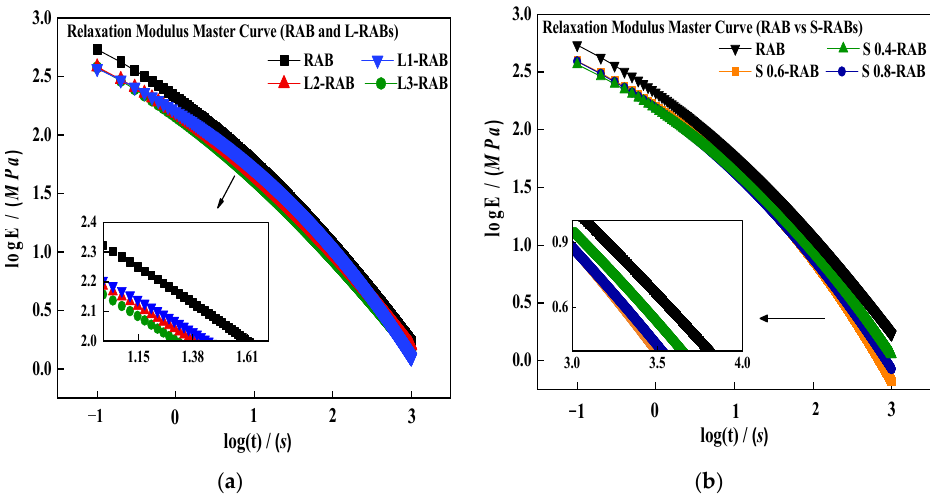
Figure 7. The master curves of 𝐸(𝑡) for W-RABs at a reference temperature of − 12 ℃ . ( a ) RAB and L-RABs; ( b ) RAB and S-RABs.